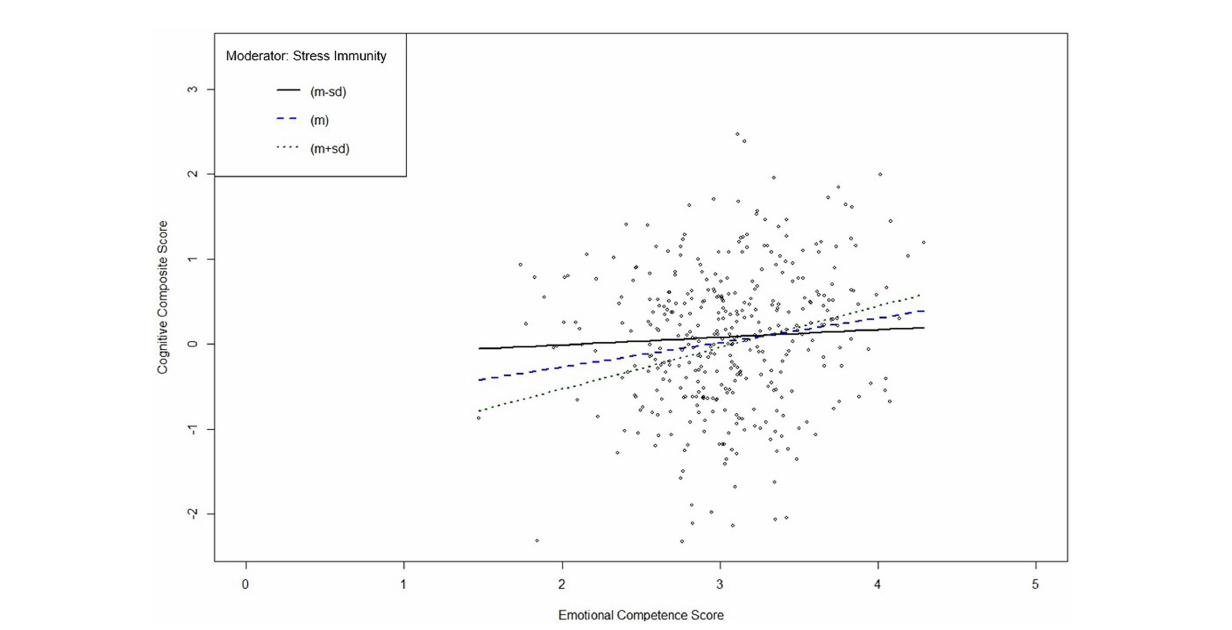
FIGURE 1 Interaction plot of the simple slope analysis of psychopathic personality trait “Stress Immunity” in individuals with depression. m , mean; sd , standard deviation. Simple slope analysis of the moderating effect of “Stress Immunity” on the relationship between the Emotional Competence Score and the Cognitive Composite Score indicates a significant moderation effect at high (+1 sd above m ; solid black line) and low ( − 1 sd below m ; dotted black line) values of “Stress Immunity” ( m is represented by the blue dashed line). Subsequent significance tests indicate a significant positive moderating effect for individuals with depression and high values in “Stress Immunity,” but not for individuals with depression and low values in “Stress Immunity.”